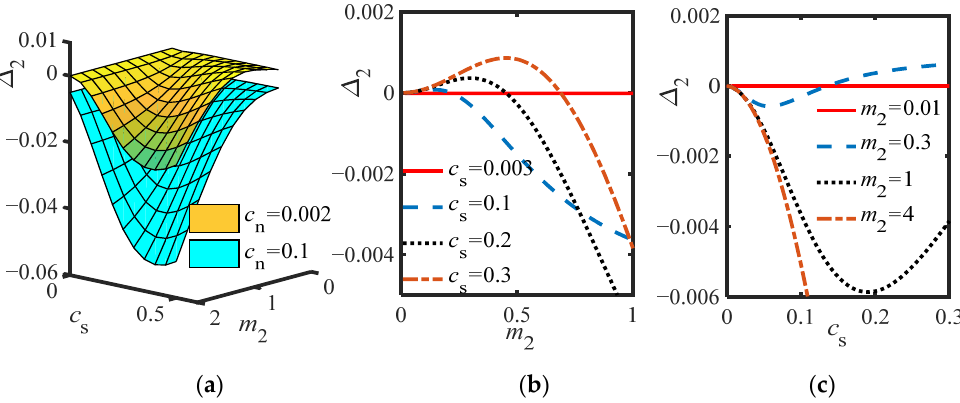
Figure 4. ( a ) Δ 2 vs. c s and m 2 at different c n; ( b ) Δ 2 vs. m 2 at different c s ( b n = 0, c n = 0.002); ( c ) Δ 2 vs. c s Figure 4. ( a ) ∆ 2 vs. c s and m 2 at different c n ; ( b ) ∆ 2 vs. m 2 at different c s ( b n = 0, c n = 0.002); at different m 2 ( b n = 0, c n = 0.002). ( c ) ∆ 2 vs. c s at different m 2 ( b n = 0, c n =